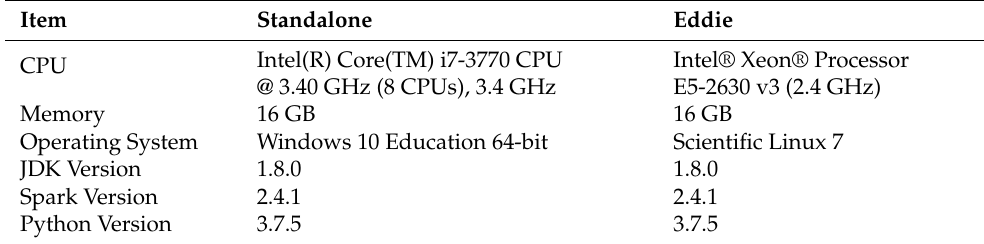
Table 1. Experimental setup for both stand-alone and Eddie